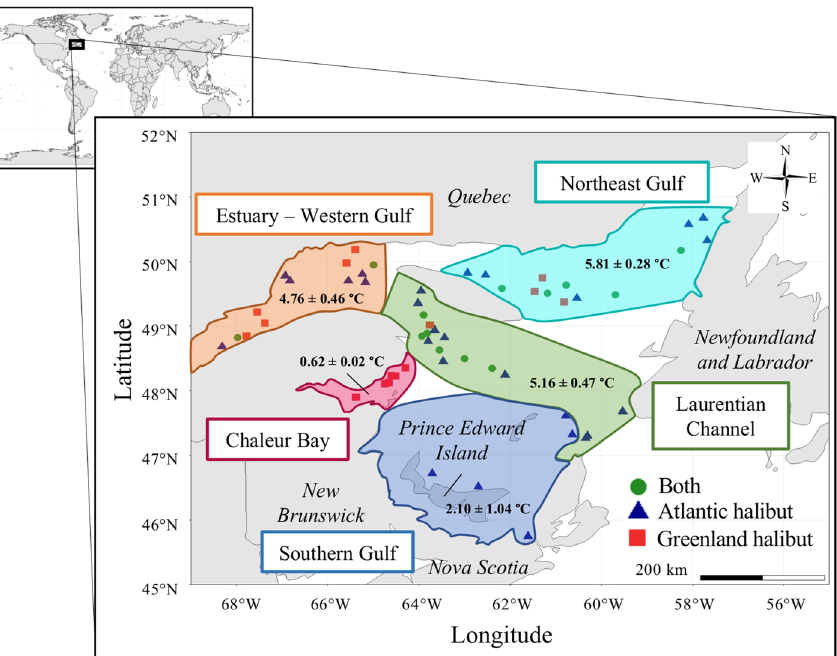
Figure 1. Map of the sample sites divided into five different areas. The regional temperature is given for each zone (mean ±